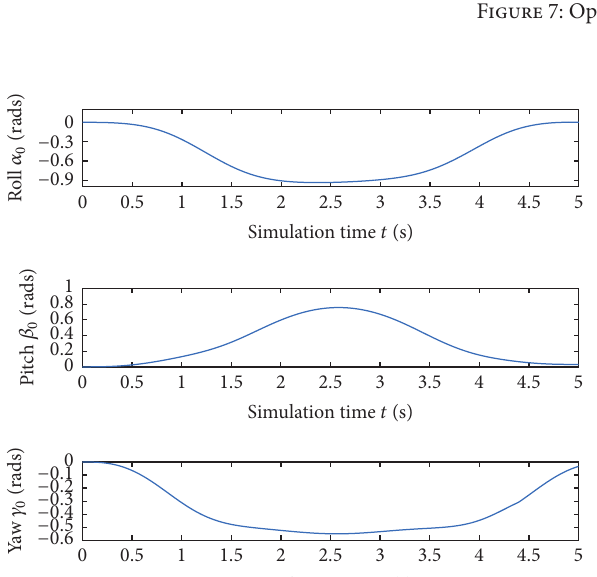
Figure 7: Optimal joint curves.